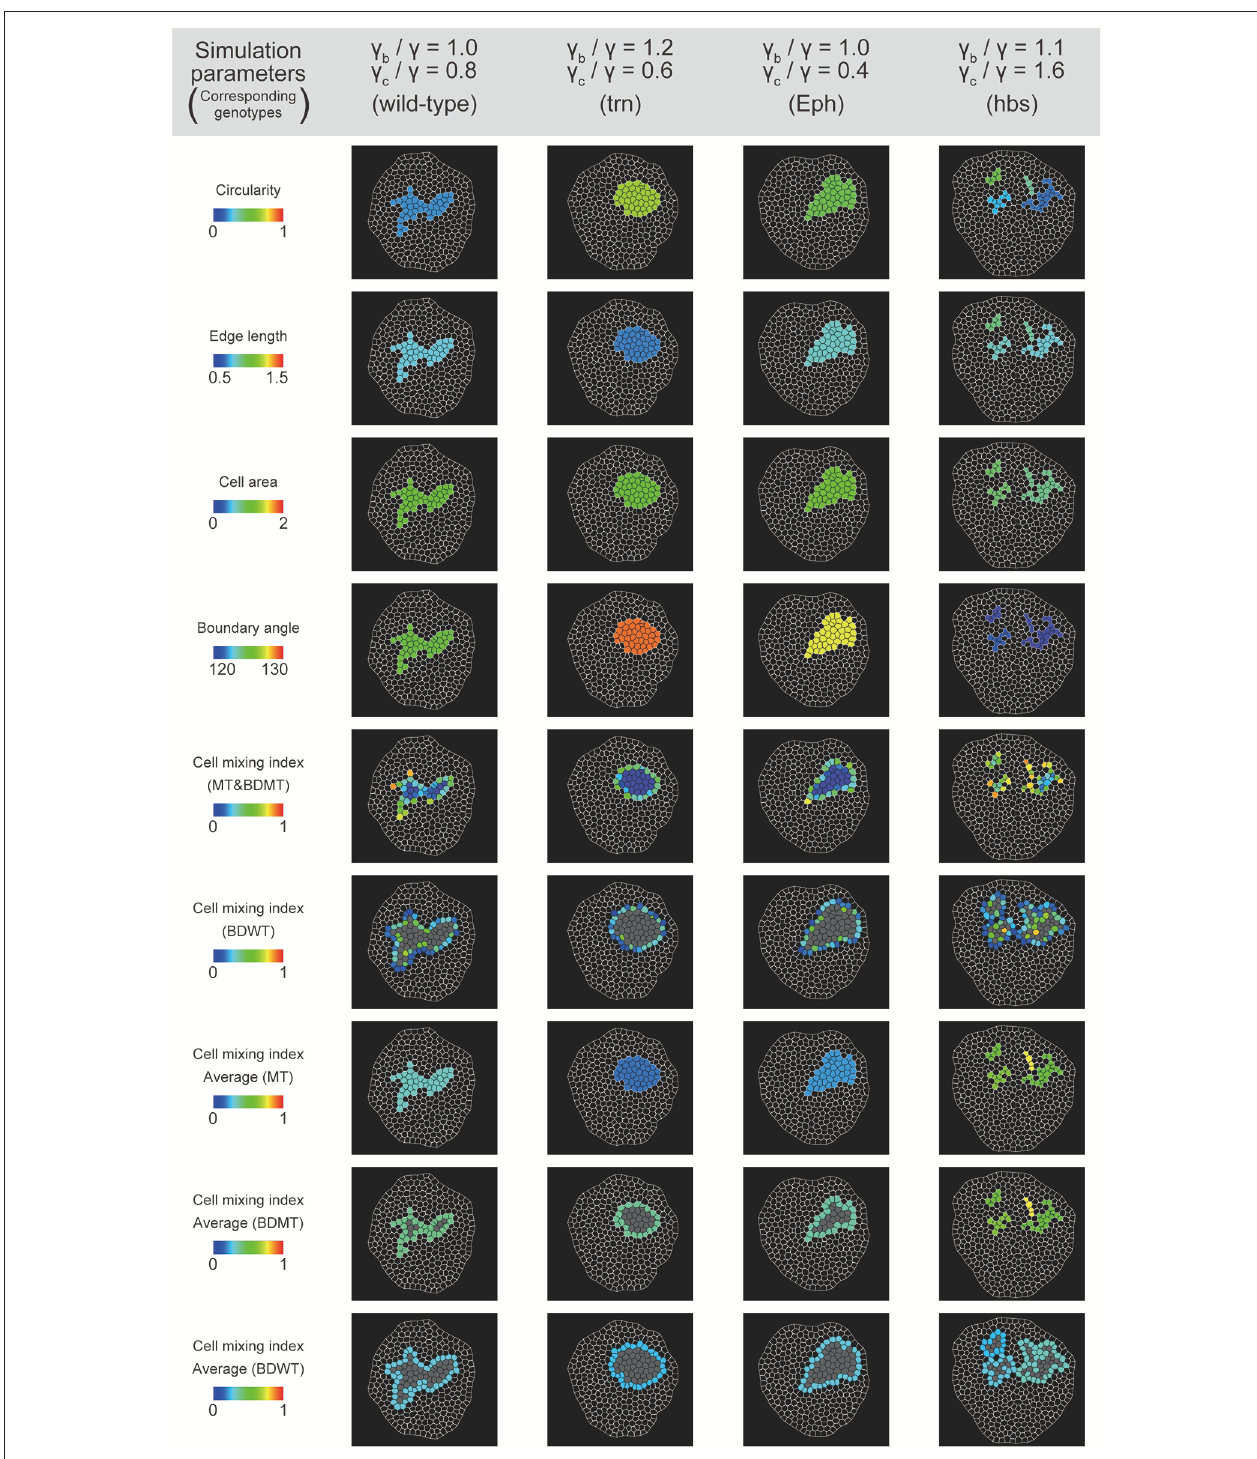
FIGURE 6 | Simulation clones corresponding to the experimental clones. Visualization of individual criteria for the four simulated clones, which correspond to the best representative combination of line tension parameters for the four genotypes (pentagon asterisks in Figure 5B ).